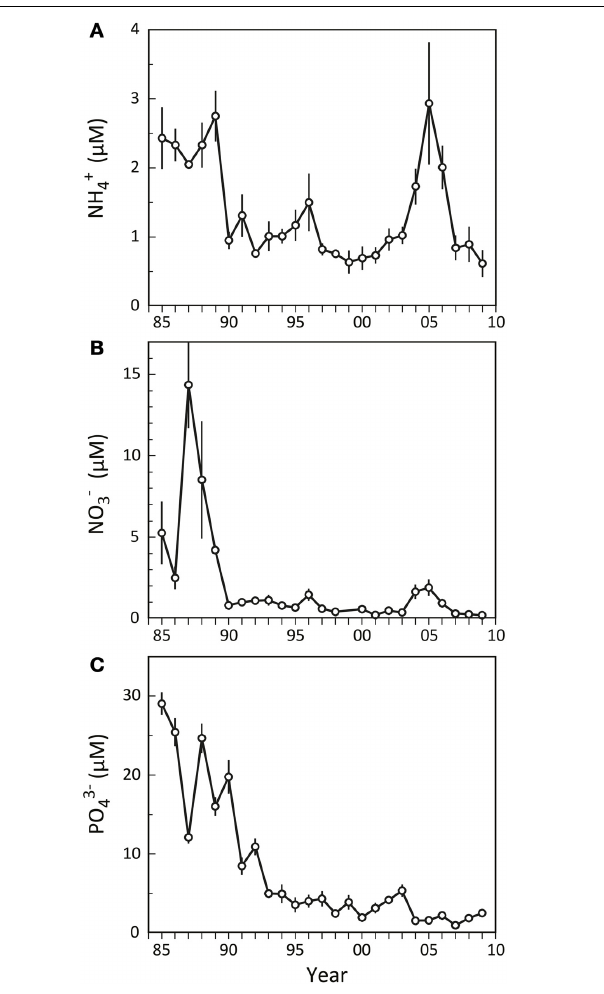
FIGURE 2 | Summer nutrient levels (A: NH + 4 ; B: NO − 3 ; C: PO 3 − 4 ) in the water column of the inner part of Odense Fjord from 1985 to 2009. Samples were taken in June–August at station OF122. Error bars indicate ± SE [ n = 3 (1985–1992); 7 (1993–1997); 12 (1998–2001); 26 (2002–2006); 10 (2007–2009)] (data kindly provided by The Danish Nature